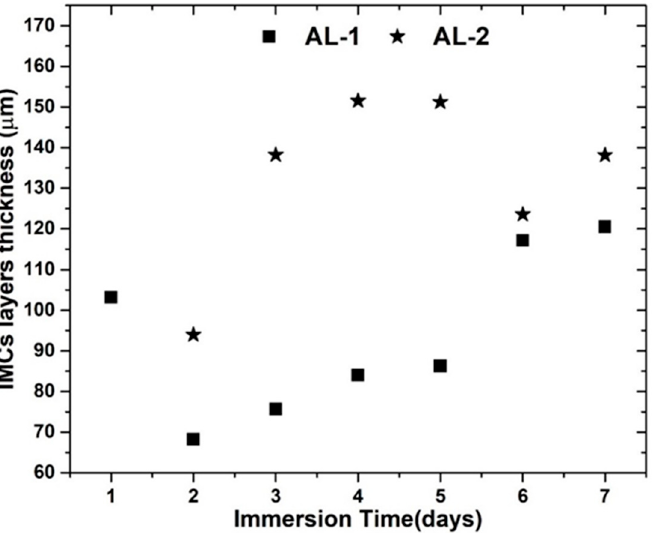
Figure 8. Change in the IMC layers (AL-1 and AL-2) thickness with immersion time (1 to 7 days) at 600 °C.